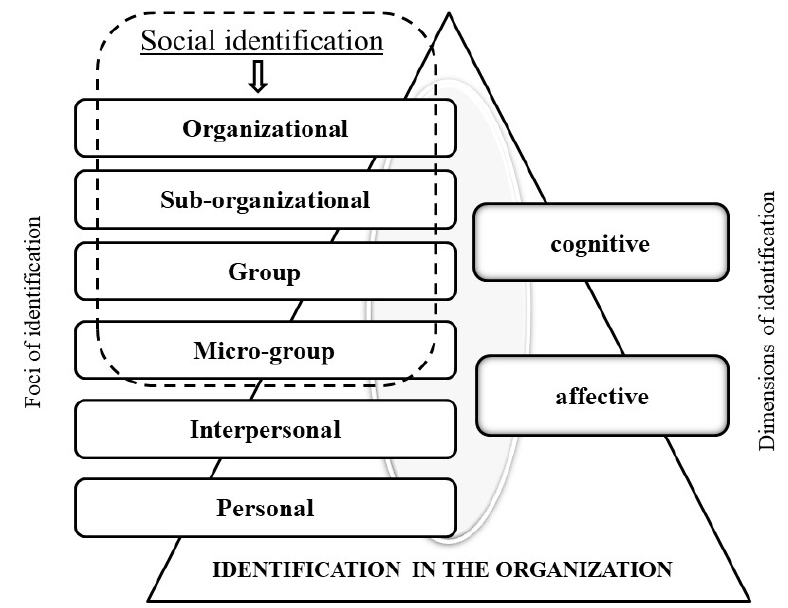
Figure 1. A Multidimensional Conceptual Model of Employee ID in an